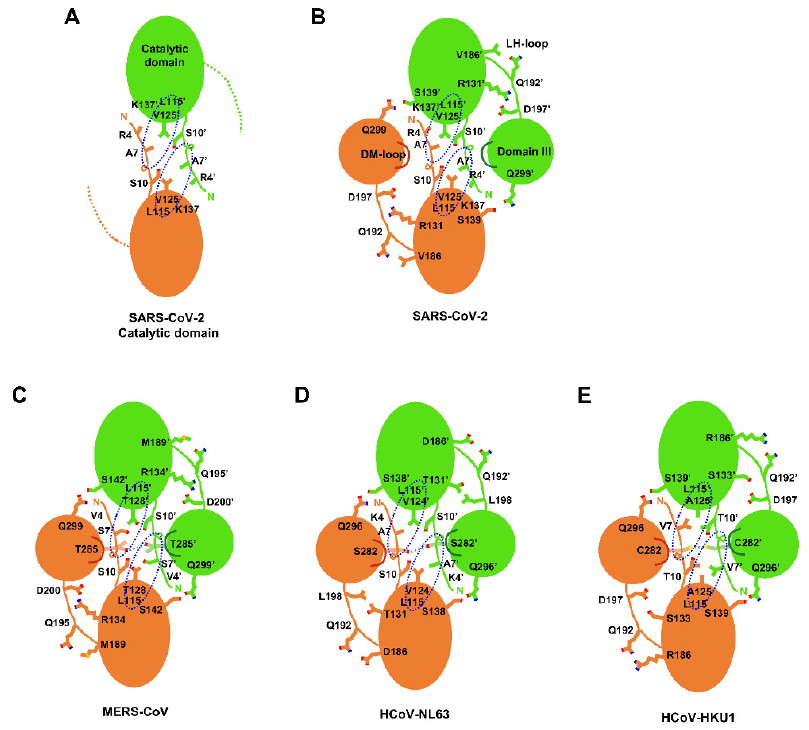
Figure 2. Key interactions involved in dimerization. The two subunits were drawn with different colors, and key residues were represented by a stick model. The distances of hydrogen bonds between residues on domain III are found in the text. The dotted blue circles indicate where hydrophobic pockets exit. ( A ) the catalytic domain of SARS-CoV-2 3CLpro; ( B ) SARS-CoV-2 3CLpro; ( C ) MERS- CoV-2 3CLpro; ( D ) HCoV-NL63 3CLpro; ( E ) HCoV-HKU1 3CLpro.